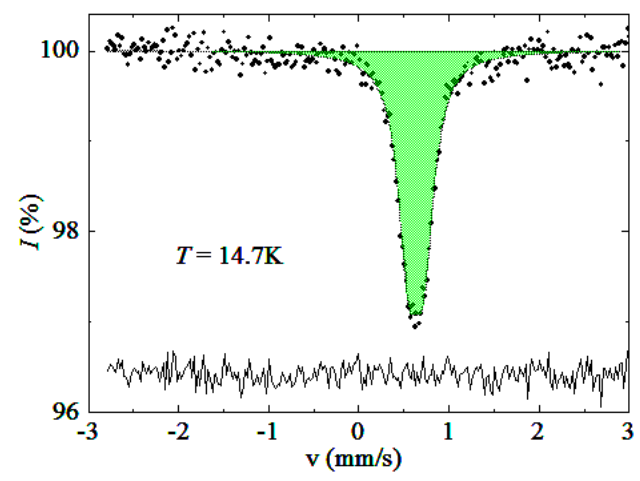
Figure 4. 57 Fe Mössbauer spectrum of Eu 7 Cu 36 Fe 8 As 23 recorder at 15 K.